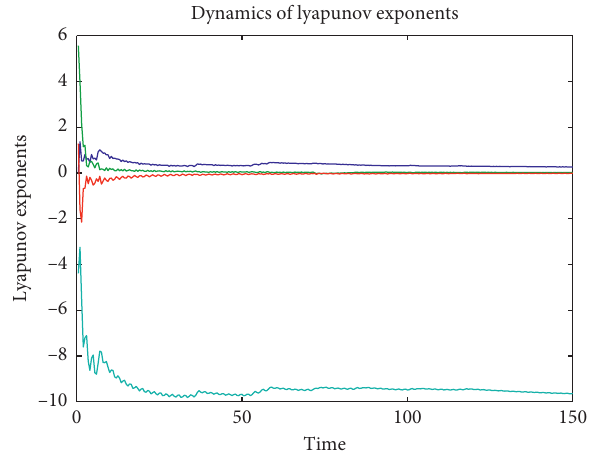
Figure 5: Dynamics of Lyapunov exponents with respect to Case 2.